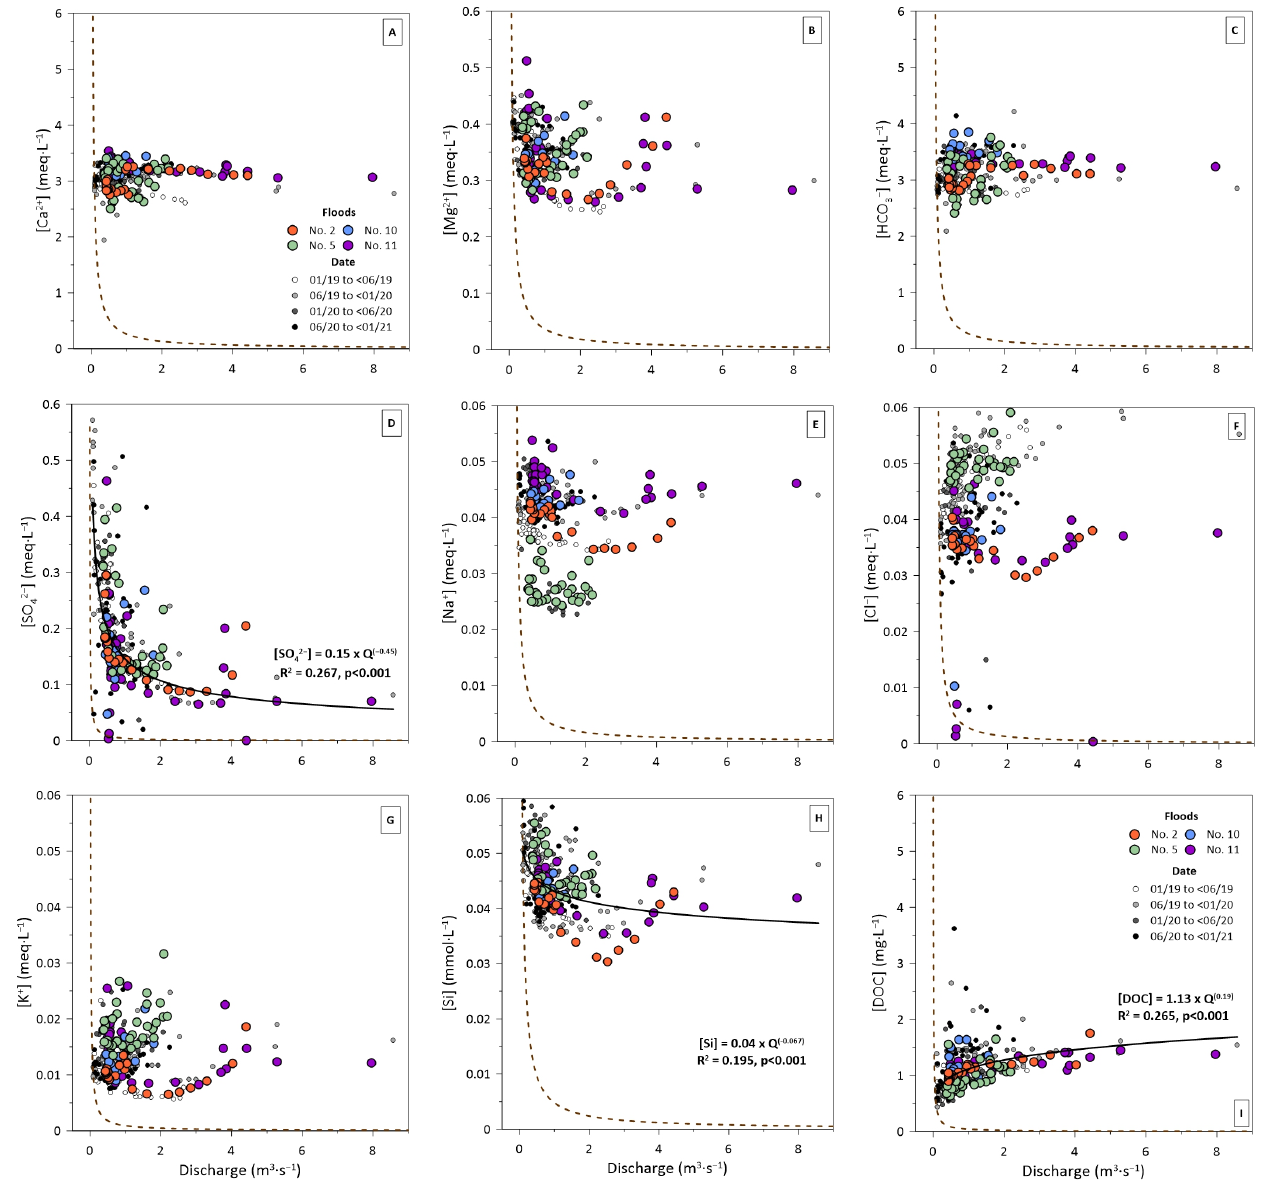
Figure 4. C-Q relationships for the major dissolved elements: ( A ) for Ca 2+ , ( B ) for Mg 2+ , ( C ) for HCO 3 − , ( D ) for SO 4 2 − , ( E ) for Na + , ( F ) for Cl − , ( G ) NO 3 − , ( H ) Si, and ( I ) DOC. The theoretical dilution curve (brown dashed line) represents a dilution of the concentration during the non-influenced baseflow by deionized water (b = − 1, Equation (3)). The studied floods events are mentioned, as well as the background data discriminated according to four periods.